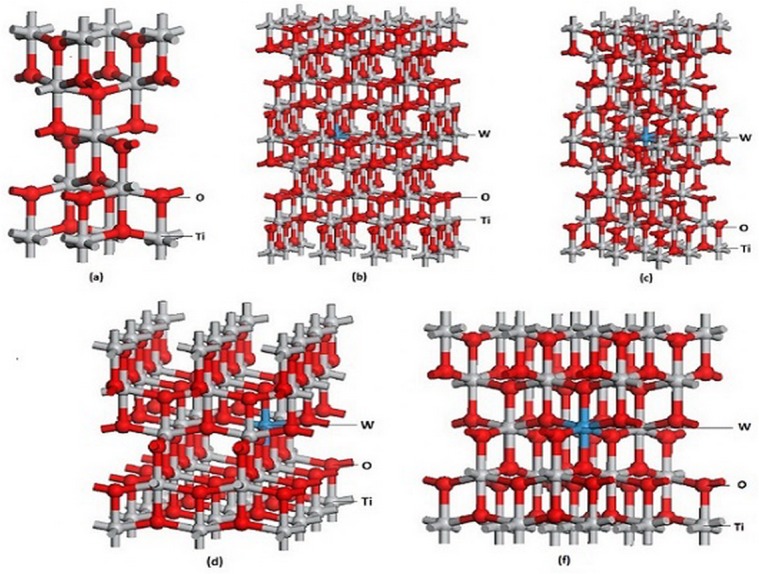
Theoretical models.(A) pure anatase TiO2 unit cell, (B) Ti0.97917W0.02083O2 supercell, (C) Ti0.96875W0.03125O2 supercell, (D) Ti0.95833W0.04167O2 supercell, (F) Ti0.9375W0.0625O2 supercell.